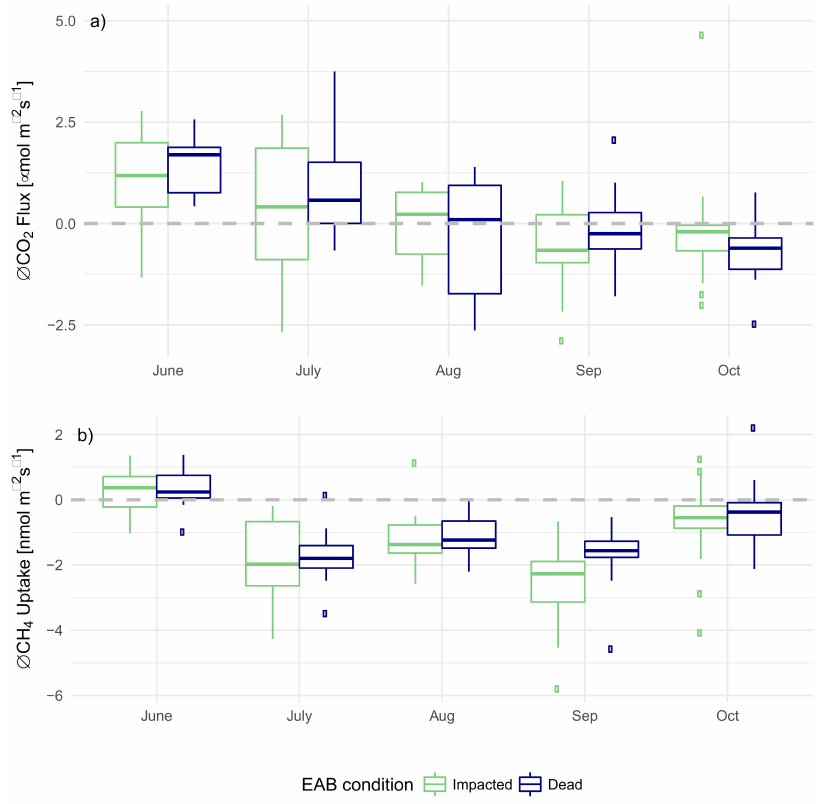
Figure 6. Monthly CO 2 flux and CH 4 uptake differences in 2016 and 2017 organized by trees that were stressed by emerald ash borer (EAB) during the experiment (Impacted) or already dead at the start of the experiment (Dead): ( a ) monthly soil CO 2 flux 2016–2017 differences and ( b ) monthly soil CH 4 uptake 2016–2017 differences had no consistent trends. Whether a tree was impacted by EAB during the experiment or dead from the start of the experiment did not have a significant impact on soil CO 2 flux or CH 4 uptake differences between 2016 and